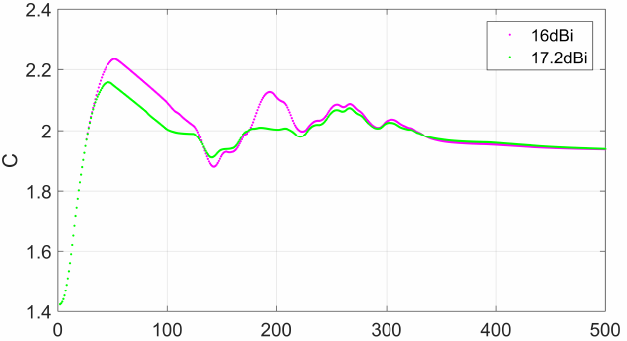
Figure 7. Aggregation coefficient of AGVs with antenna gain of 16 dBi and 17.2 dBi. Different antennas are used to represent different channel conditions. The figure shows the aggregation coefficients at each sampling point under different channel